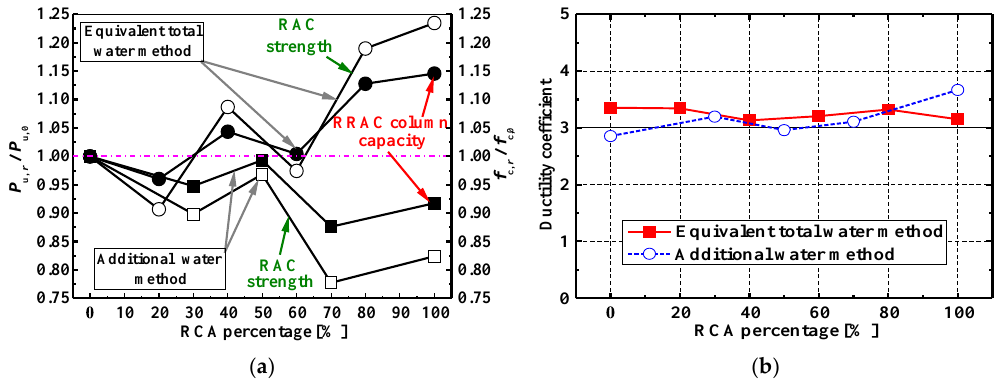
Figure 9. Effect of RCA percentage on seismic performance of RRC columns (Note: P c,0 is the ultimate lateral load when r = 0%; P c,r is the ultimate lateral load when r ≠ 0%). ( a ) Capacity. ( b ) Ductility.